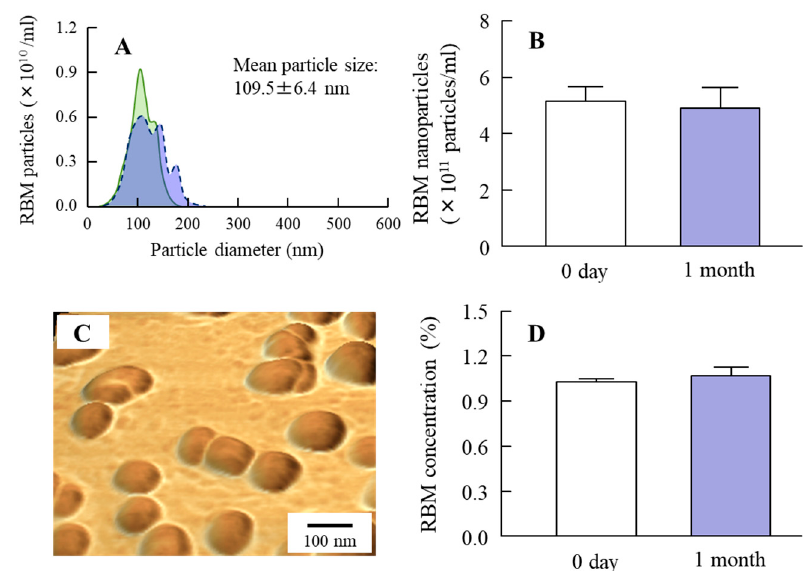
Figure 3. Changes in particle character and concentration of RBM-NDs 1 month after the preparation. ( A ) Particle size frequencies of RBM in RBM-NDs 0 days (solid line, green) and 1 month (dashed line, blue) after the preparation. ( B ) Changes in particle number of RBM nanoparticles in RBM-NDs. ( C ) AFM image of RBM in RBM-NDs. ( D ) RBM concentration in RBM-NDs. n = 6. The particle in RBM-NDs remained nano size (30–220 nm) 1 month after the production, and no difference in particle number, form, or concentration were observed between 0 days and 1 month after preparation.